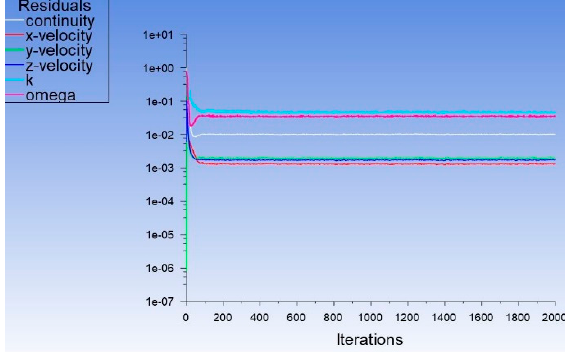
Figure 9. Residual change curve of the steady-state calculations.